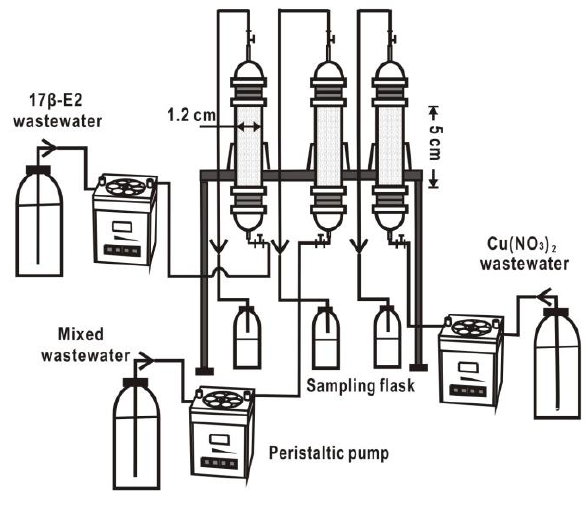
Figure 2. Soil aquifer treatment (SAT) soil column setup. Table 2. Physical and chemical characteristics of soil in soil aquifer treatment (SAT)